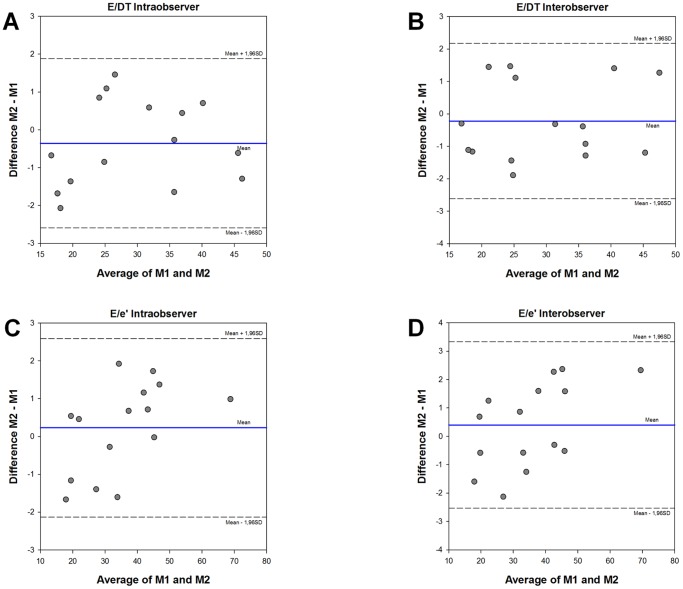
Intra- and interobserver variability of E/DT (A, B) and E/e' (C, D) presented as Bland-Altman plots.M: measurement. Dashed lines present the limits of agreement (Mean ±1.96 SD).